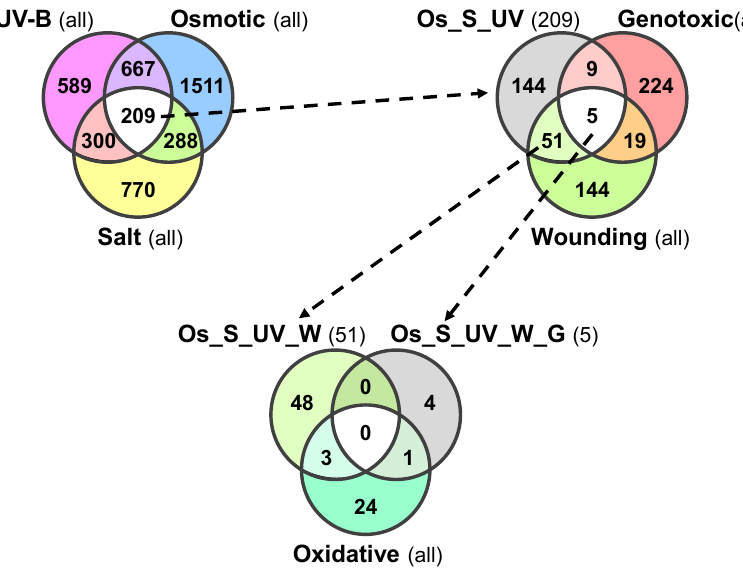
Figure 5. Number of putative PCESR genes that responded during most abiotic stress treatments. Overlapping UV-B light, osmotic and salt stress responsive genes are labeled Os_S_UV. Wounding, UV-B light, osmotic and salt stress responsive genes (Os_S_UV_W) or genotoxic, wounding, UV-B light, osmotic and salt stress responsive genes (Os_S_UV_W_G) are indicated accordingly. The base number of genes contained in each set is indicated in